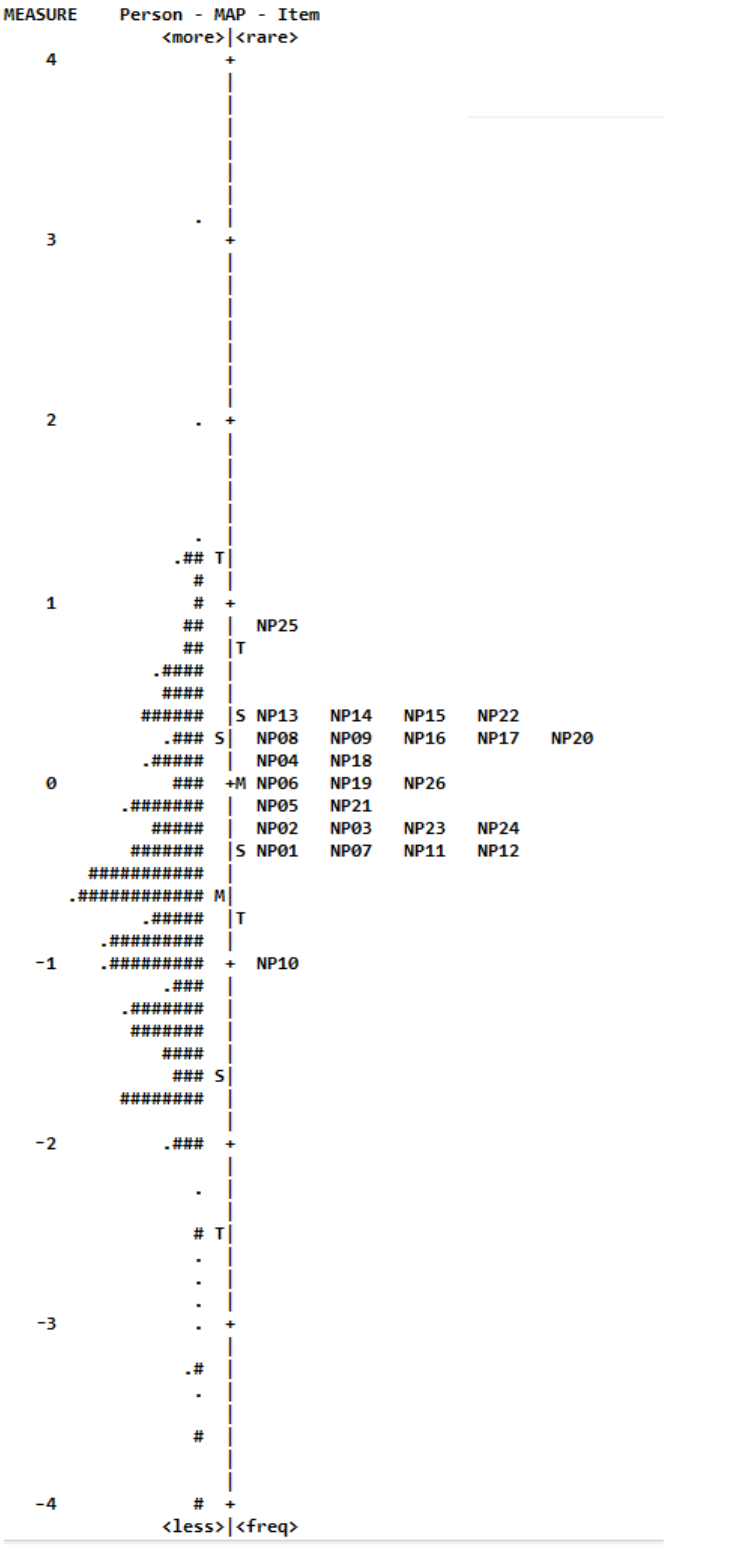
Figure 1. Person-item Wright Map. The persons are on the left of the vertical line, and items are located on the right of the vertical line. More able (narcissism) persons are located at the top of the map. More difficult (severe) items are located at the top of the map. Each “#” represents 2 persons. Each “.” represents 1 person (M = mean; S = 1 standard deviation from the mean; T = 2 standard deviations from the mean).